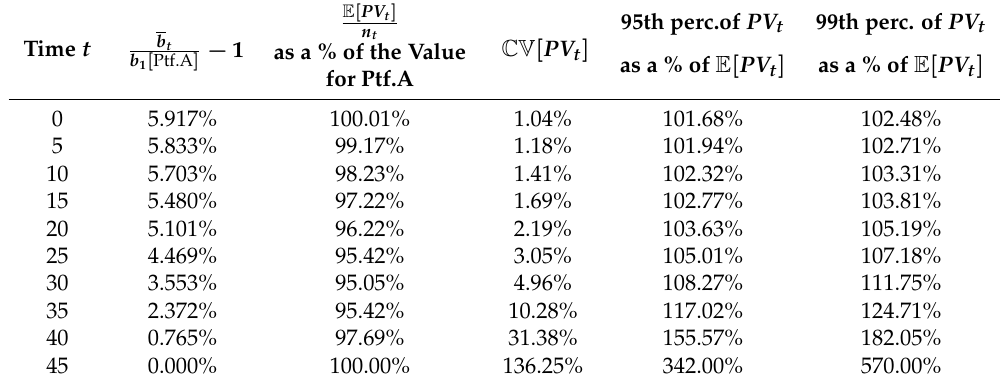
Table 18. Portfolio G: portfolio average benefit amount (additional amount with respect to the standard benefit for Portfolio A,